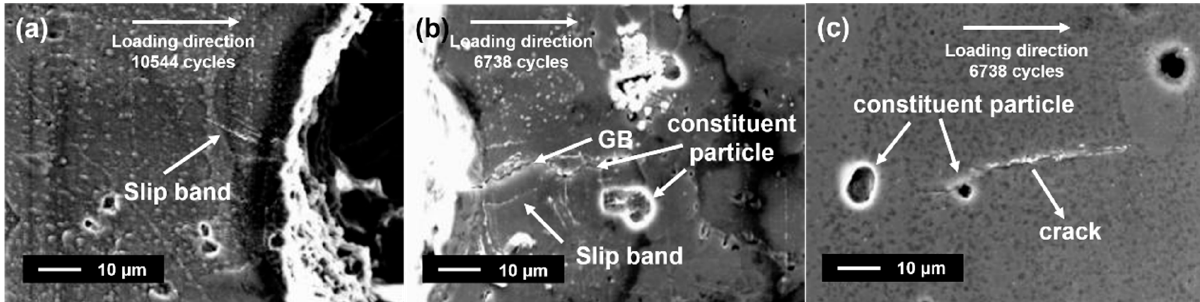
Figure 11. Micrographs for ( a ) the Low Fe alloy at loading of 10,544 cycles and ( b , c ) the High Fe alloy loading of 6738 cycles.